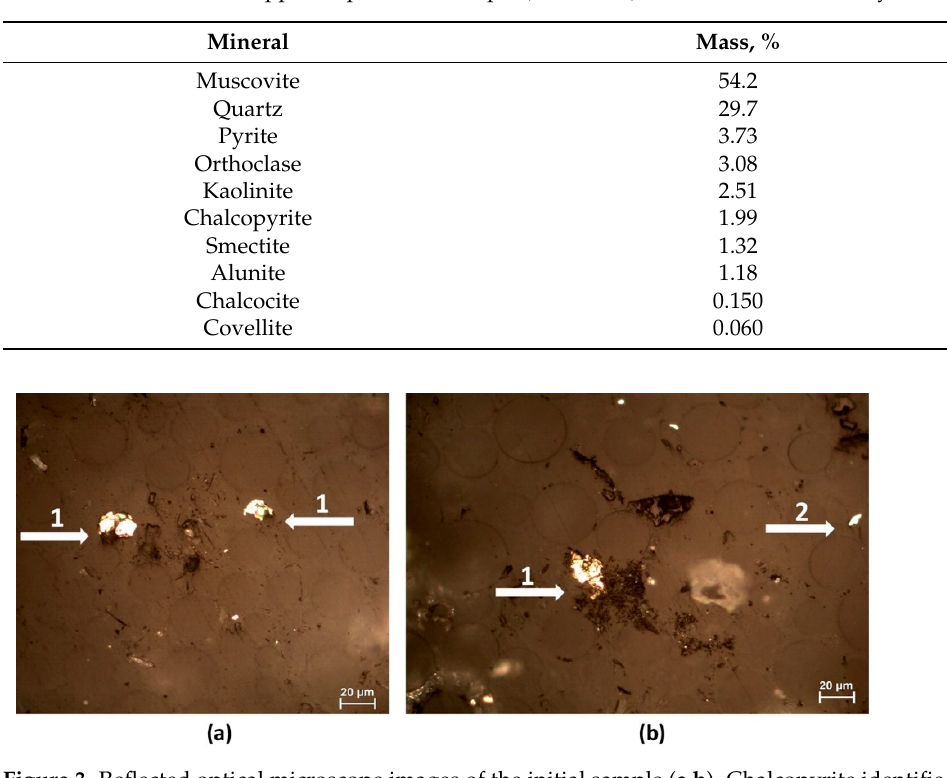
Figure 4. SEM image of the initial sample at various magnifications: ( a ) ×650, ( b ) ×2,000. In ( b ), 1: chalcopyrite, 2: pyrite, and 3: muscovite. EDS analysis in ( c ) of chalcopyrite, in ( d ) of pyrite, and in ( e ) of muscovite. 3.2. Characterization of Cured Ore Samples The pretreatment products that were obtained (agglomerated solids) were character- ized to identify the newly formed products. Figure 5 shows the characterization performed by optical microscope conducted over a sample with a pretreatment using 15 kg/t H 2 SO 4 , 25 kg/t NaCl, and 15 days as curing time. A chalcopyrite particle with green edges was observed, showing the formation of new products. These products were associated with copper sulphate or chloride–copper complexes, as evidenced by Quezada et al. [26]. In Figure 5b, a similar behavior was evi- denced but with a greater intensity in the formation of the reaction products around the particle.